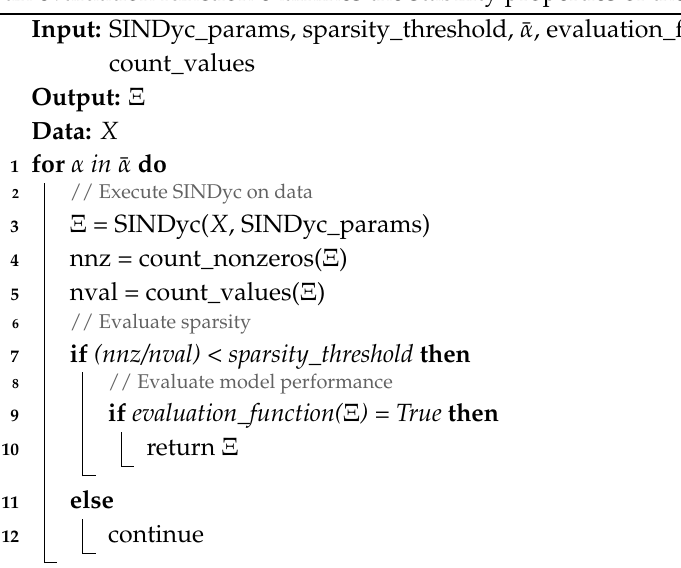
Algorithm 1: Sweep over the set of regularization coefficients ¯ α and identification of SINDyc models. It returns Ξ when the sparsity level satisfies a chosen criterion, and at a minimum, an evaluation function examines the stability properties of the